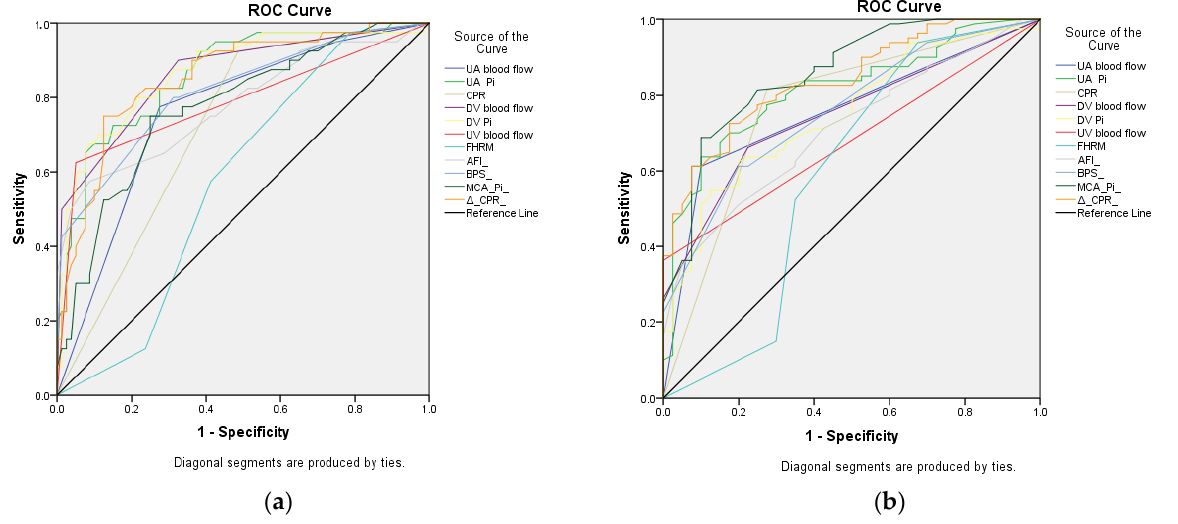
Figure 1. ROC curve for early preterm fetal growth restriction comparing: ( a ) Neonates with morbid- ity/mortality (bad outcome) with neonates with acidosis/asphyxia but without neonatal morbidity and neonates without neonatal morbidity/acidosis/asphyxia (good outcome); ( b ) Neonates with morbidity/mortality with neonates and acidosis/asphyxia but without neonatal morbidity (bad outcome) with neonates without neonatal morbidity/acidosis/asphyxia (good